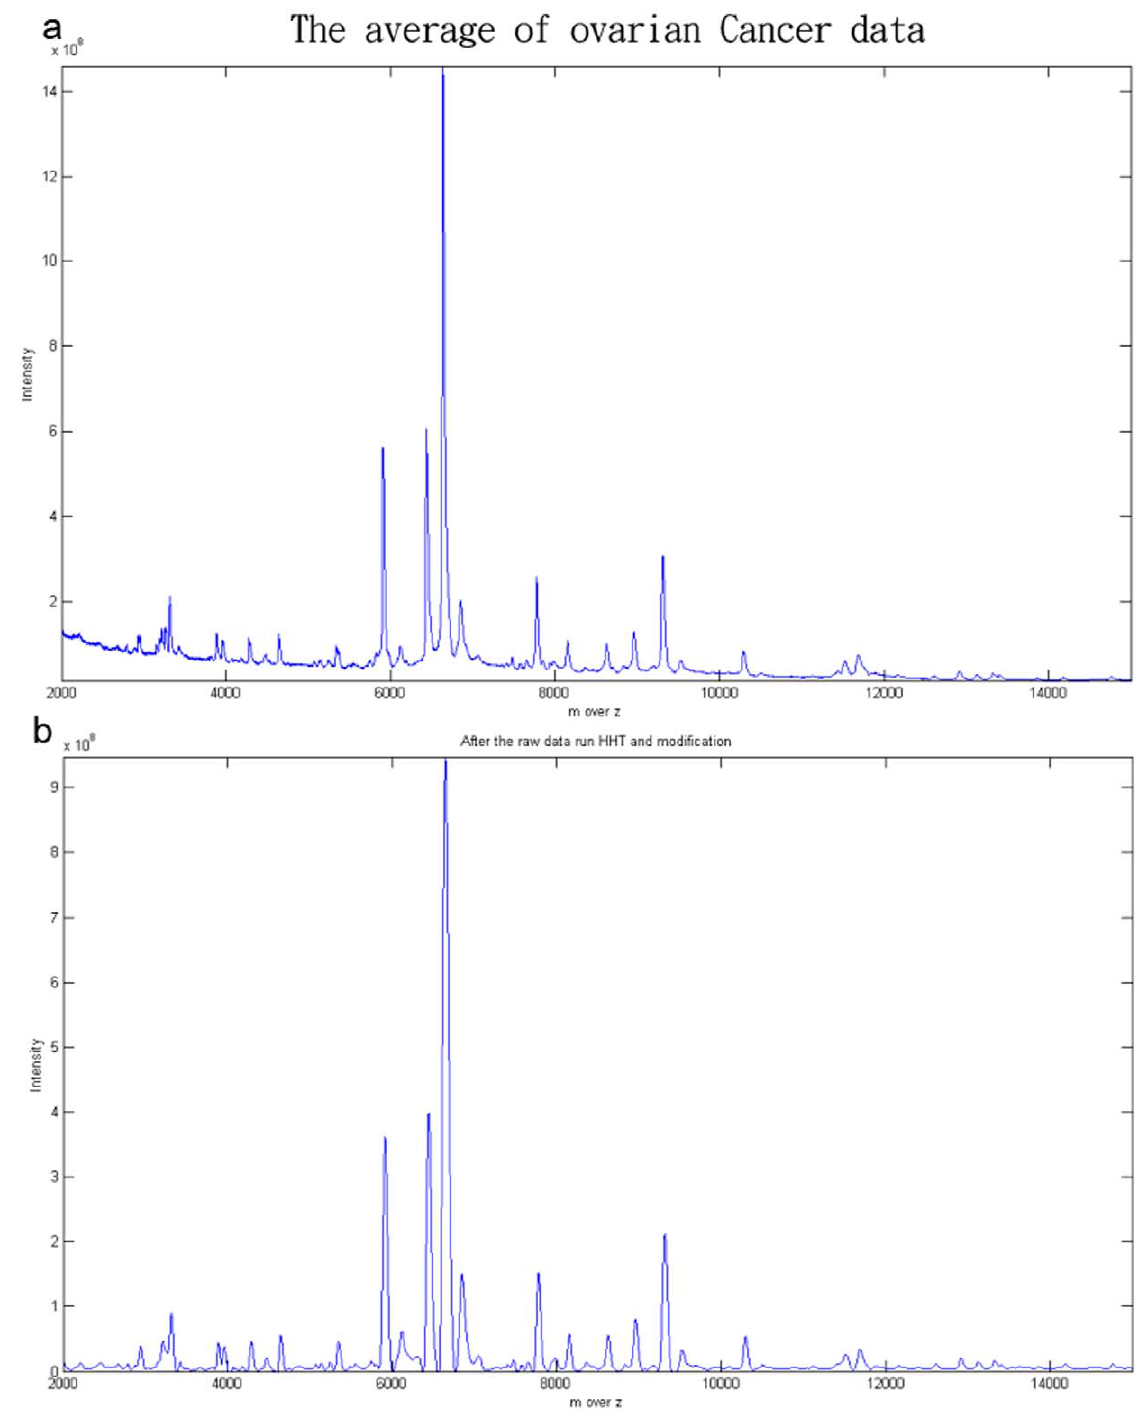
Figure 2. Before and after HHT preprocessing. (a) The average of fifty ovarian cancer datasets. There are greater amounts of noise in the low region than in the high region. The scale is approximately ten to the ninth power. (b) The same figure after using the Hilbert Huang transformation formula and the various modifications carried out after preprocessing. When comparing with (a), it can be seen that the chief peaks and the profile are maintained.